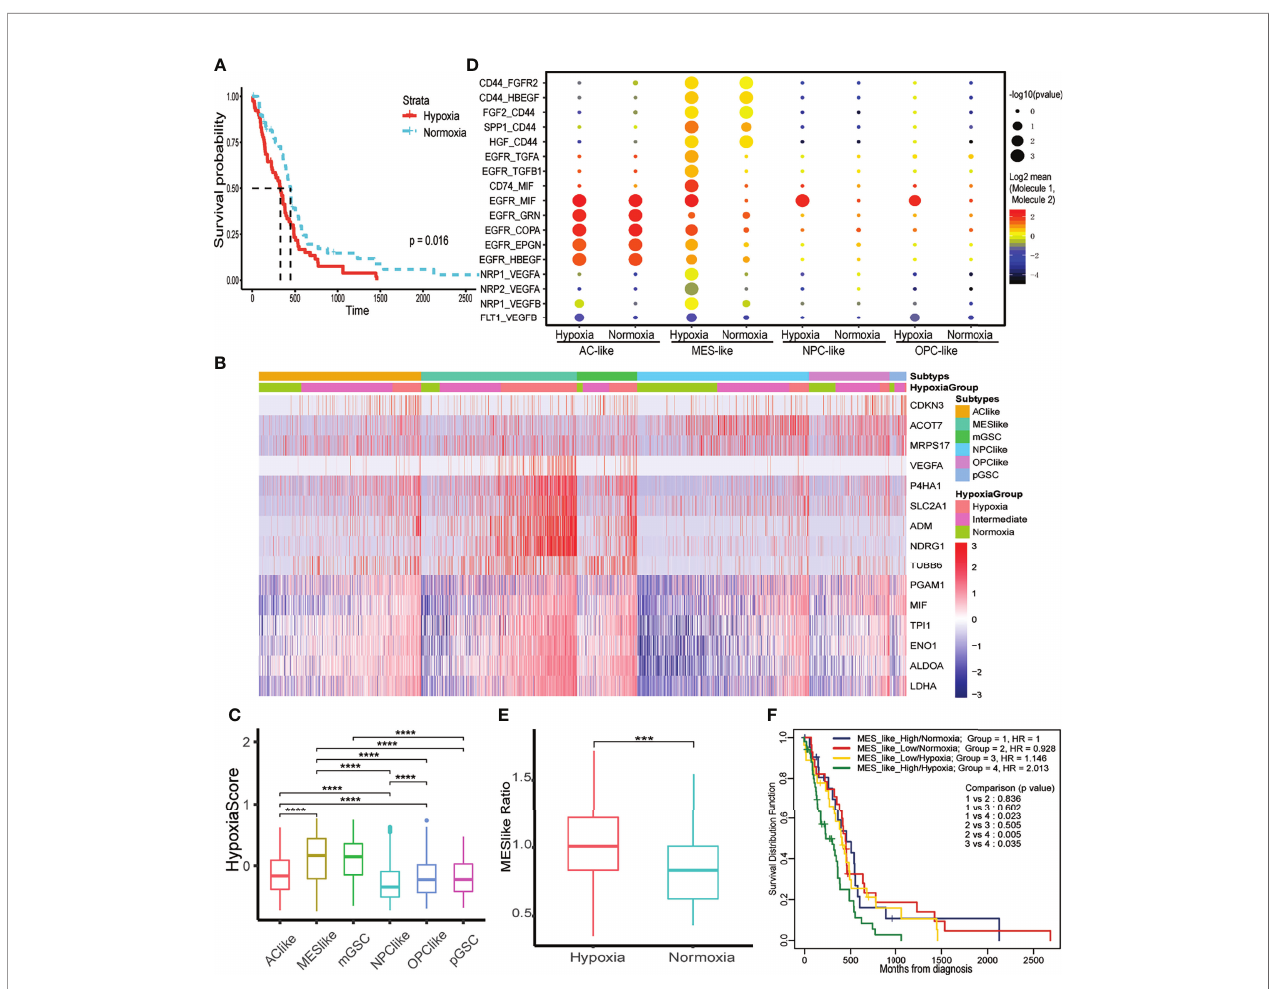
FIGURE 2 | The effect of hypoxia on tumor cells and prognosis. (A) Kaplan – Meier curve of different hypoxia status of primary IDH wild-type GBM in TCGA database. (B) The expression of 15 hypoxia-related genes in GBM tumor cells. (C) The distribution of hypoxia score within each tumor cell type. (D) Intercellular communications within each tumor subtype. (E) Distribution of MES-like cell proportion within TCGA primary IDH-wt GBM samples between hypoxia and normoxia group. (F) Two-factor Kaplan – Meier curve of TCGA primary IDH-wt GBM. The two factors were MES-like cell proportion and hypoxia status of each sample. The character ***, **** means p < 0.001 and p < 0.0001,